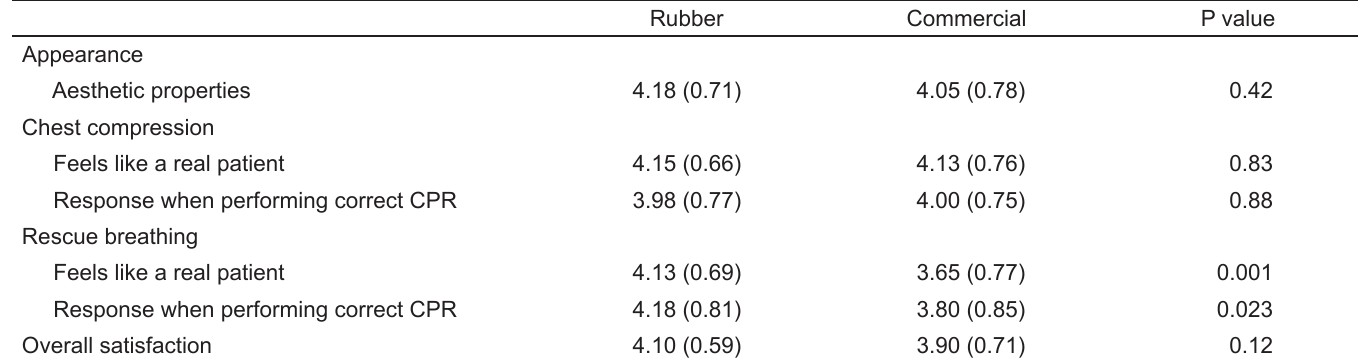
Table 1. Results of simulated cardiopulmonary resuscitation (CPR) from both types of